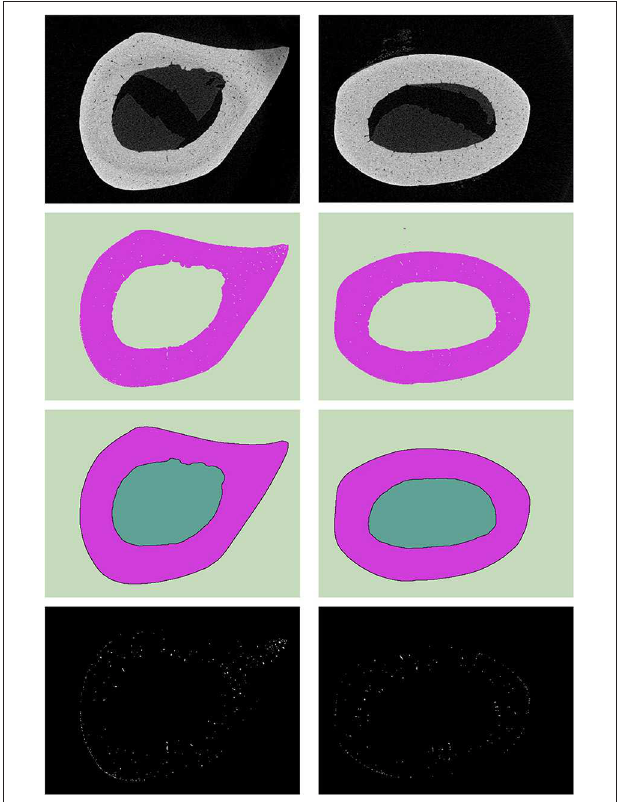
FIGURE 3 | Example of sets for two different slices (left and right sides): the first (on top)—origin data, the second—clustered data S cl , the third—smoothed data S sm , and the fourth—data of inclusions S in .